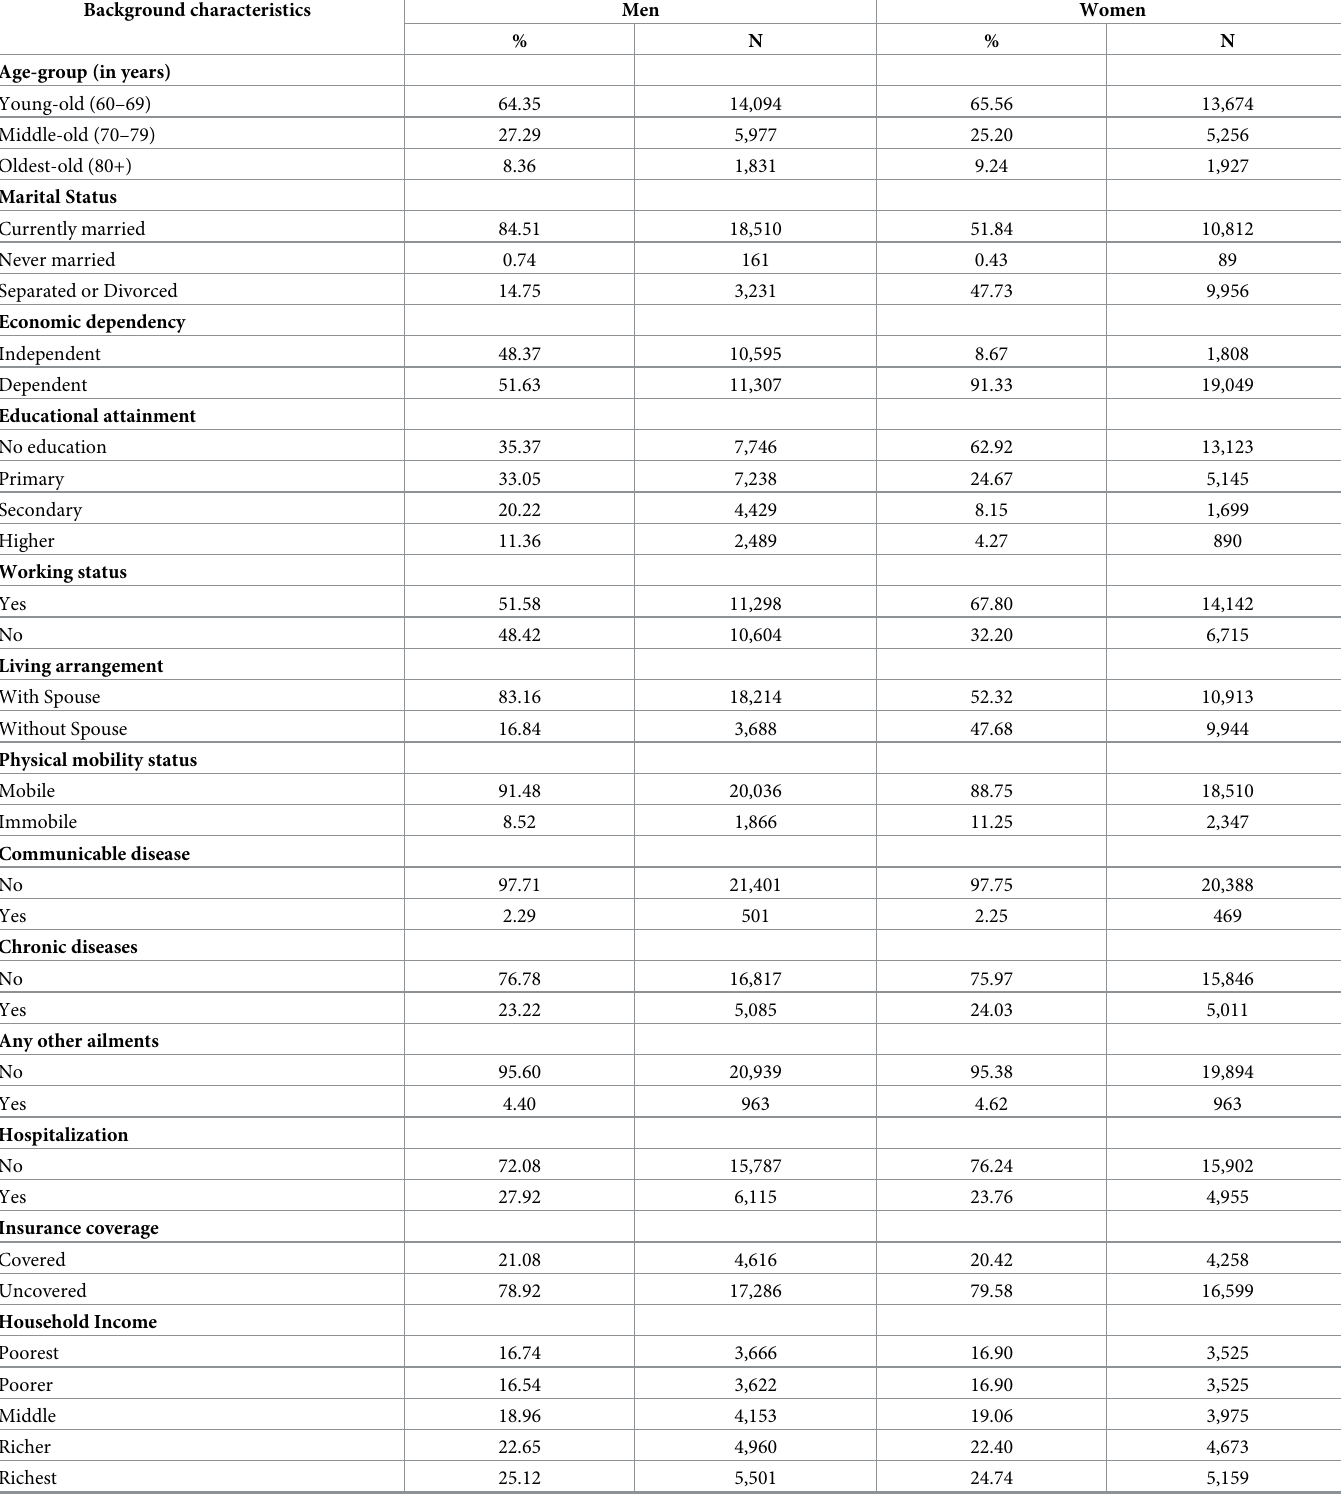
Table 1. Sample distribution of self-rated health among older adults in India by gender with suitable background characteristics, 2017–18. (n =